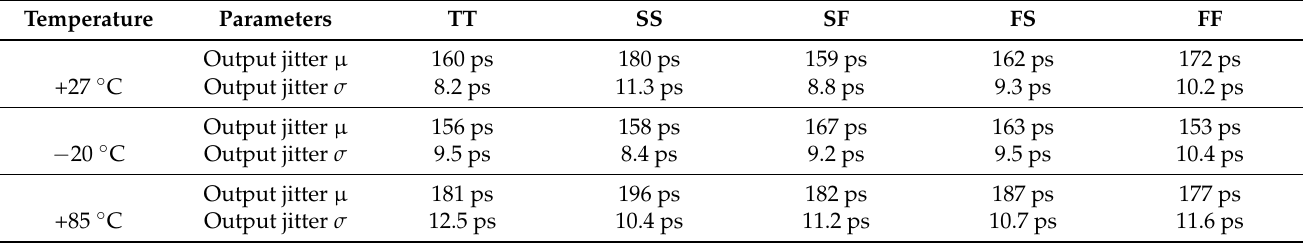
Table 3. Monte Carlo simulation results of the proposed clock multiplier under different corners and temperatures (50 iterations with relative variation ± 8% of the nominal device